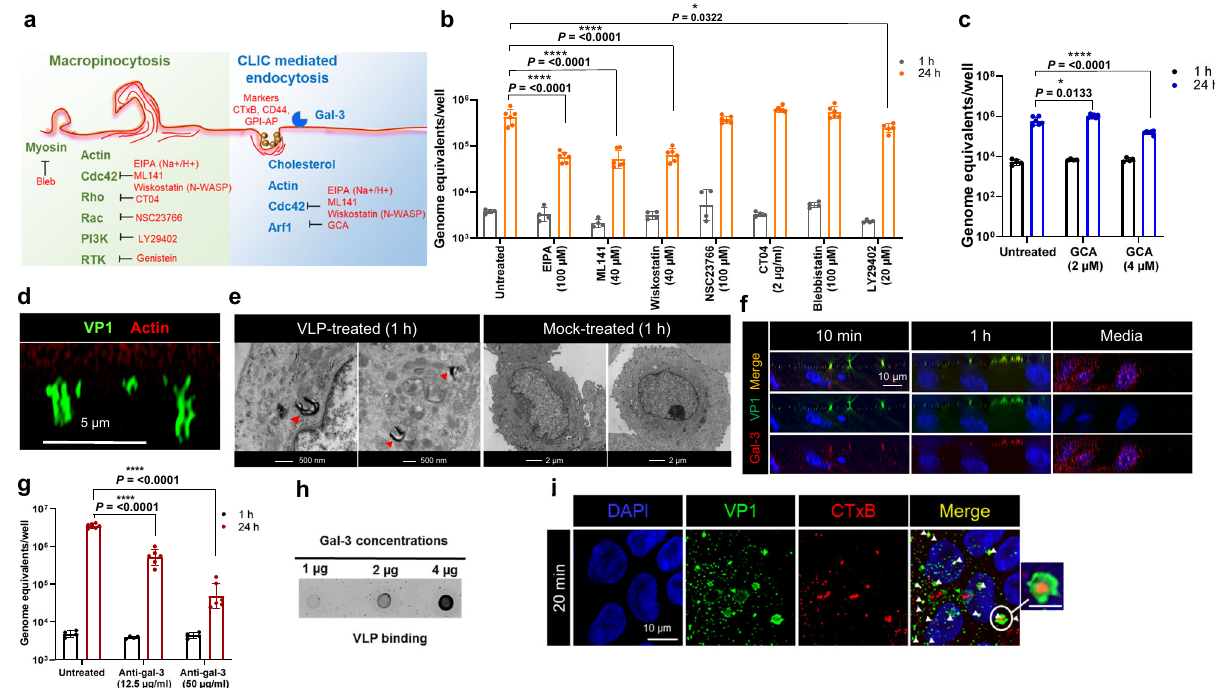
Fig. 3 | GII.4 infection in HIEs is sensitive to effectors of CLIC pathway. a Schematic of macropinocytosis and the Clathrin Independent Carrier (CLIC) pathways, their effectors and inhibitors. b GII.4 replication inthe presenceof EIPA (Na + /H + exchanger inhibitor), ML141 (Cdc42 inhibitor), Wiskostatin (N-WASP inhi- bitor), NSC23766 (RAC1 inhibitor), CT04 (RhoI inhibitor), Blebbistatin (myosin inhibitor), and LY29402 (PI3K inhibitor) at 1h (gray) and 24h (orange). c GII.4 replicationinthepresenceofArf1inhibitorGolgicideA(GCAat1h(black)and24h (blue). d GII.4-inducedtubularcarriersat1h(37 o C)detectedusingguineapiganti- Sydney VLP polyclonal antibody (Gp Syd-pAb) for viral capsid (green) and phal- loidin for actin (red). Images were taken using a ZEISS Laser Scanning Micro- scope LSM 980 with Airyscan 2. e Electron microscopy to identify CLIC structures inGII.4VLP-treatedHIEs.(1 – 7structures/cell)comparedto,mock-treatedcells(no structures in n =25cells). f Confocalmicroscopytodetect GII.4VP1capsid (green) colocalizationwithgal-3(red)onthecellsurfaceat10minand1h(37 o C)afterVLP